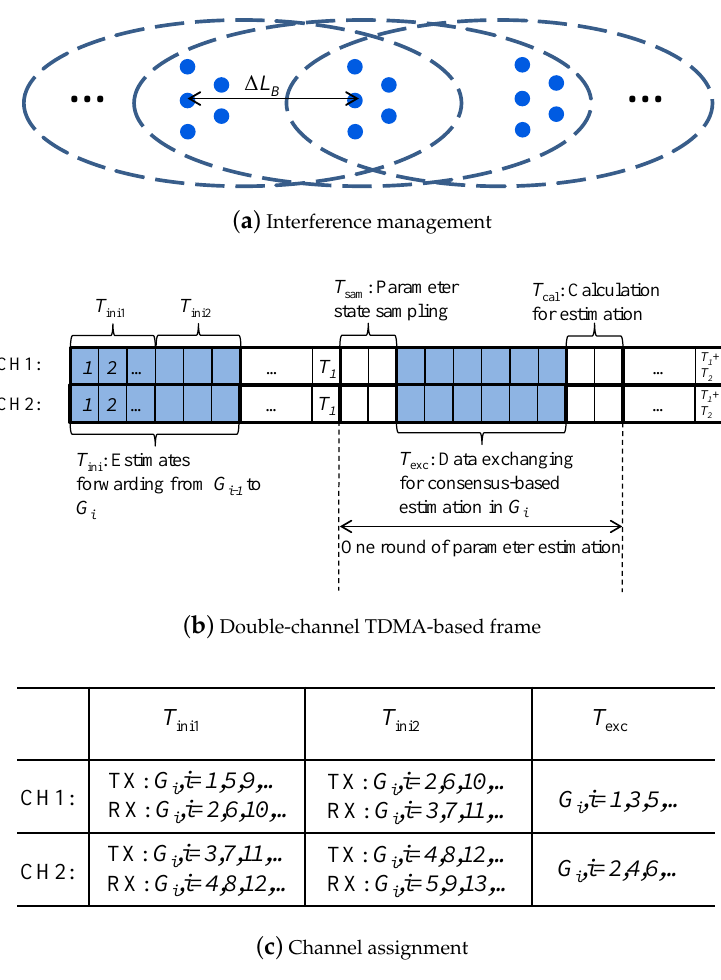
Figure 4. Illustration of TDMA-based scheduling for consensus-based sequential estimation